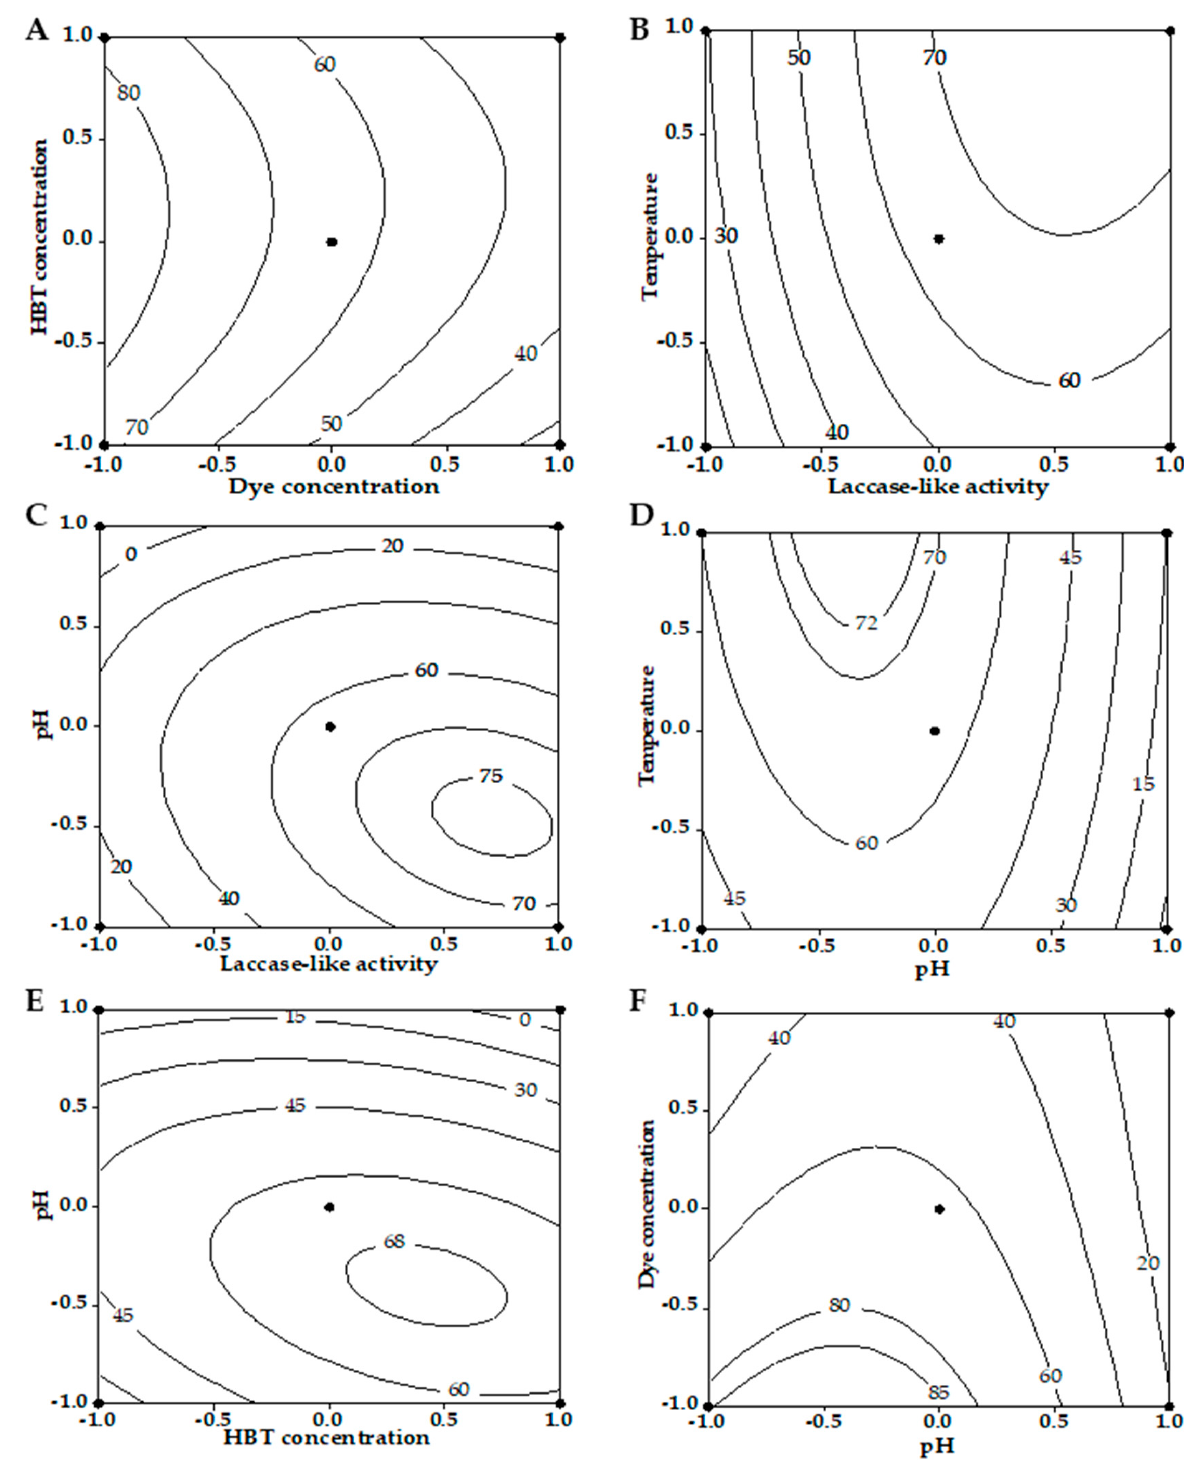
Figure 3. Iso-responses plots of RB5 decolorization as function of interactions between factors. ( A ) Dye concentration × HBT concentration interaction. ( B ) Laccase-like activity × Temperature interaction. ( C ) Laccase-like activity × pH interaction. ( D ) pH × Temperature interaction. ( E ) HBT concentration × pH interaction. ( F ) pH × Dye concentration interaction. All other factors were held at center level for each case.